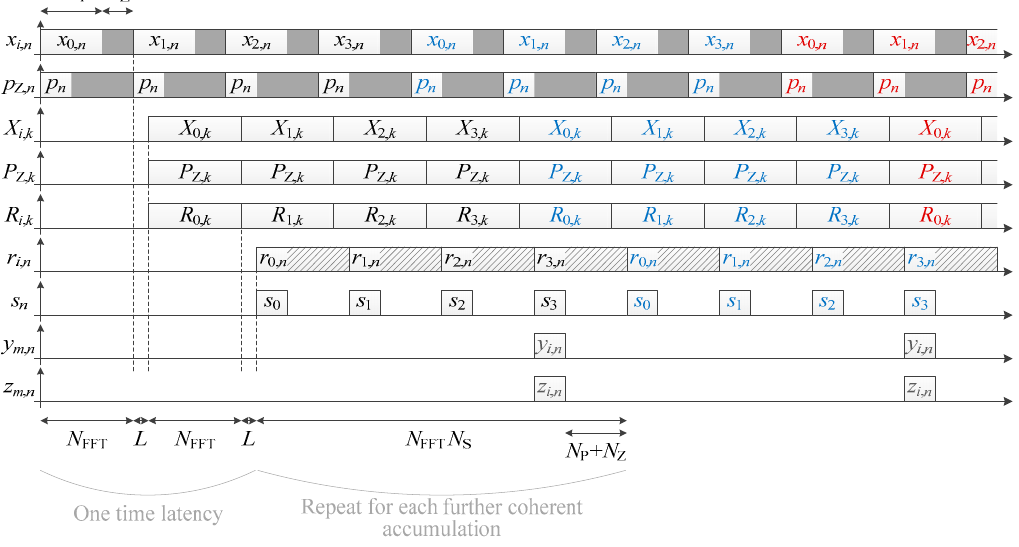
Figure 6. Implementation of a pilot channel acquisition, without non-coherent accumulation, in a serial way (timing diagram available in Figure 7).